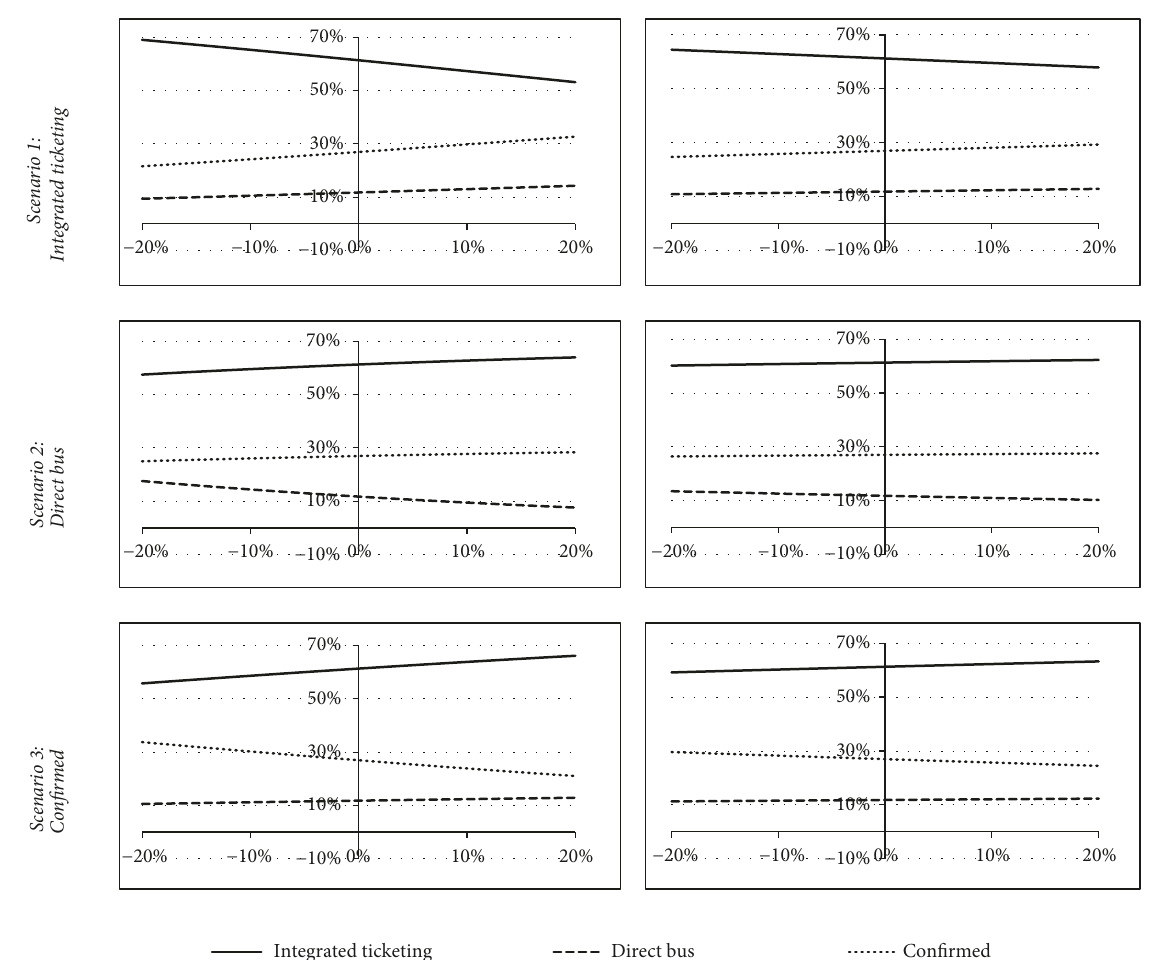
Figure 4: SP choice probability with respect to the variation of travel time or cost in one